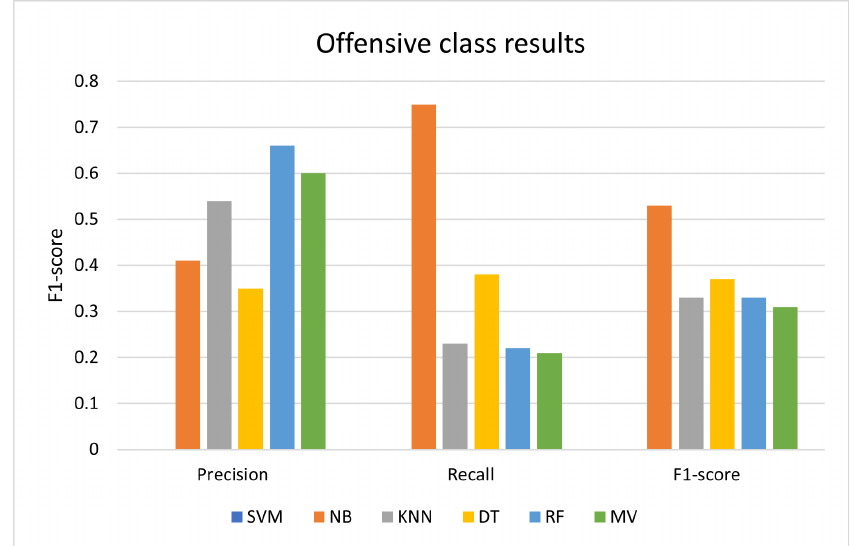
Figure 5. Offensive class results for original imbalanced dataset.